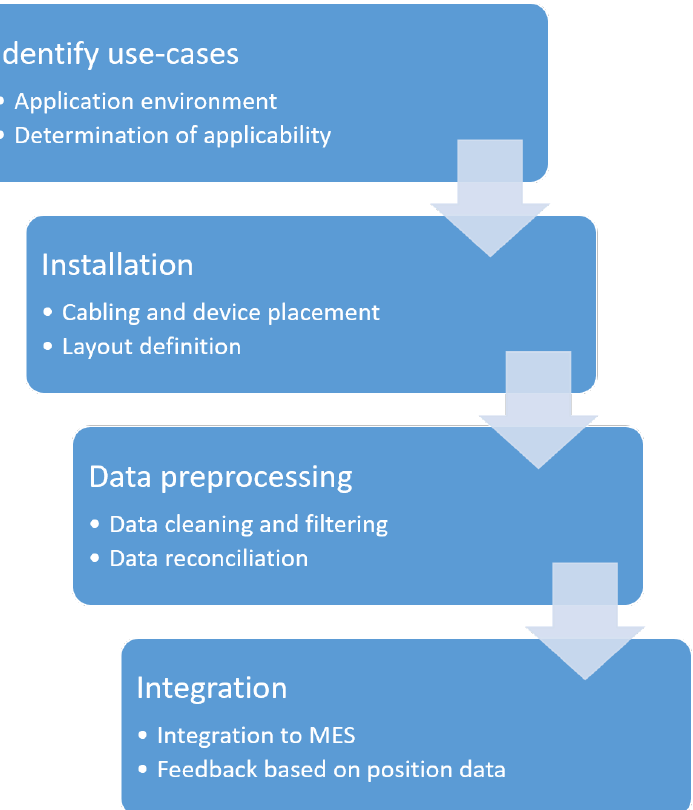
Figure 6. The full setup of RTLS in manufacturing. After the physical system installation, the layout and zone definition is necessary for system integration into the Manufacturing Execution System.